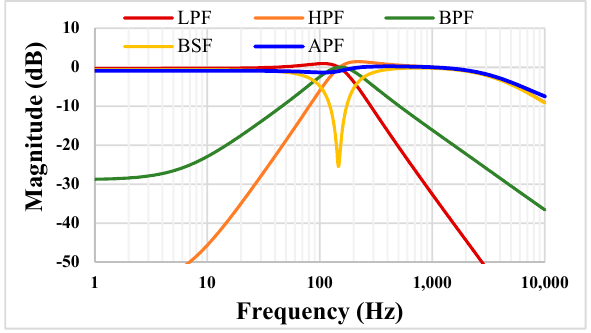
Figure 9. The simulated frequency responses of the proposed filter.